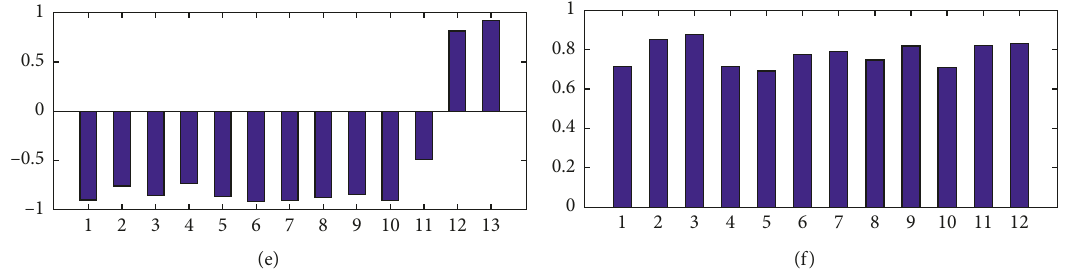
Figure 13: (a) Left heterogeneous correlation coefficients of the Arctic vortex indices (1–13) and the probability of elevation ducts. (b) Right heterogeneous correlation coefficients of the Arctic vortex indices and the probability of elevation ducts. (c) Left heterogeneous correlation coefficients and (d) right heterogeneous correlation coefficients of the Arctic vortex indices and the intensity of elevation ducts. (e) Left heterogeneous correlation coefficients and (f) right heterogeneous correlation coefficients of the Arctic vortex indices and the thickness of elevation